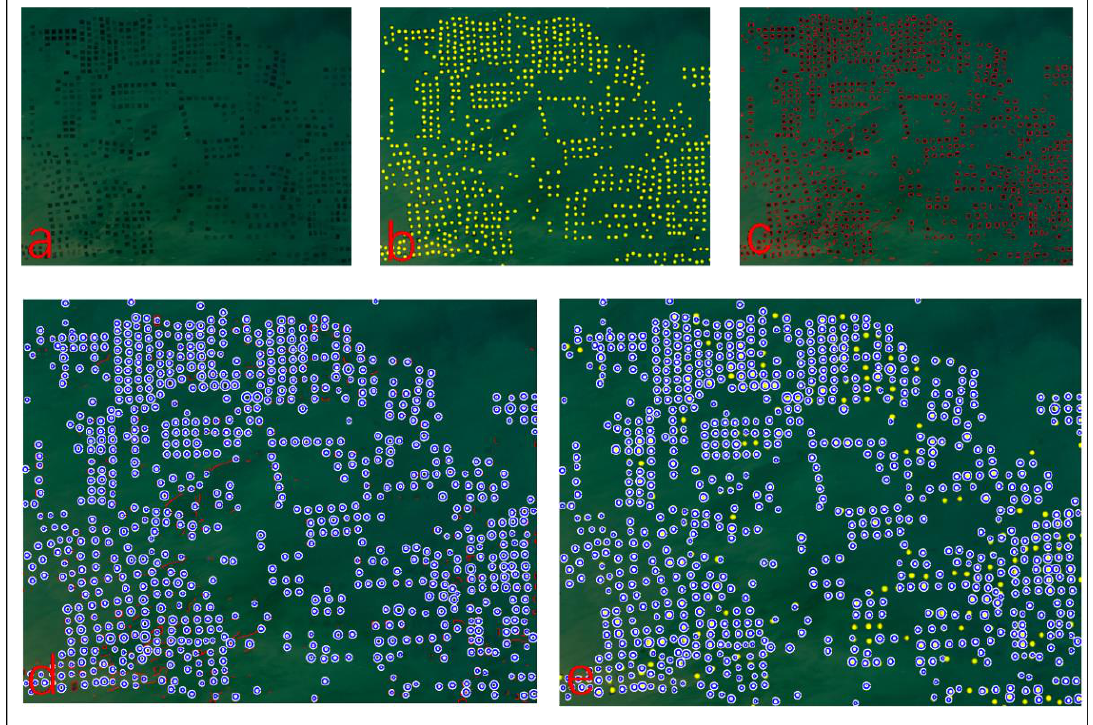
Figure 5. Experimental results in study area 1: ( a ) original image; ( b ) visual interpretation results; ( c ) identification results; ( d ) quantitative identification results; ( e ) overlap between the quantitative identification results and the visual interpretation results.